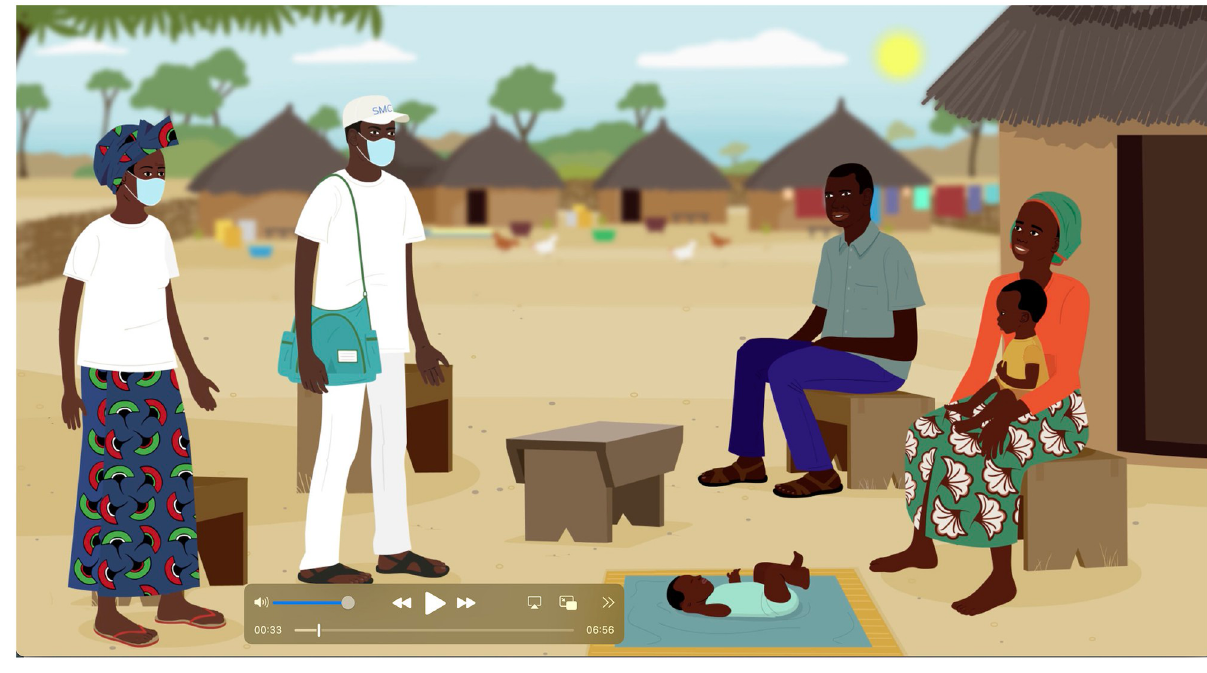
Fig 1. Screenshot from the video